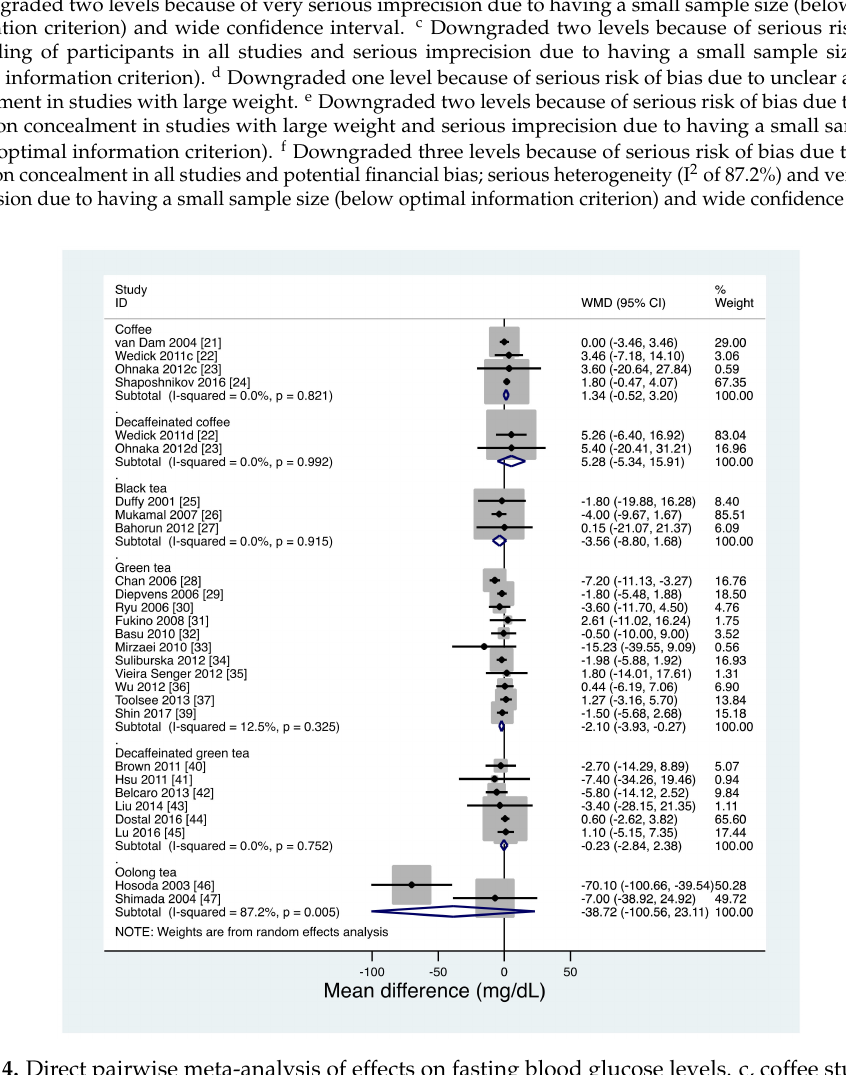
Figure 4. Direct pairwise meta-analysis of effects on fasting blood glucose levels. c, coffee study arm; d, decaffeinated coffee study